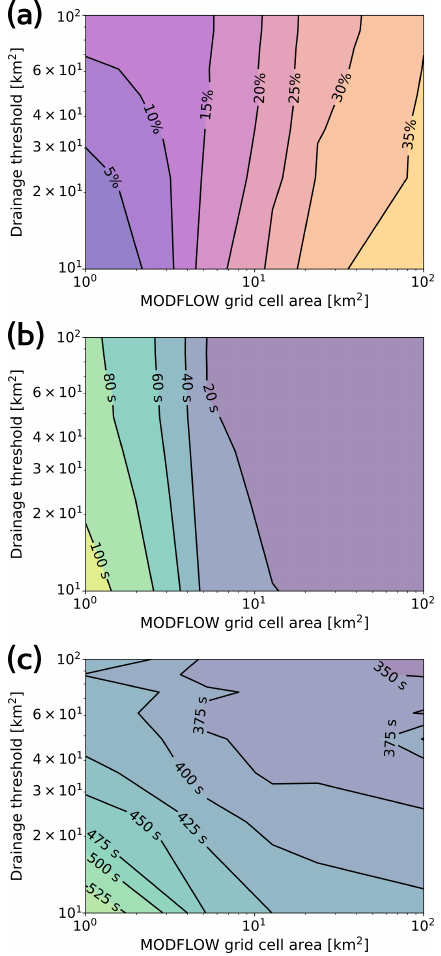
Figure 7. Changes in model output reproducibility, model runtime, and domain-building time with changes in both HRU resolution (drainage threshold) and MODFLOW resolution (MODFLOW grid cell area). (a) Root mean square error in basin discharge between each simulation and the highest-resolution simulation. (b) Time re- quired to set up the input parameters and run the model. (c) Time re- quired to build the domain. All computations were run on a Project Sputnik Dell XPS13 first-generation laptop with an Intel i7-4510U 2.0GHz CPU and 8GB of RAM running Ubuntu